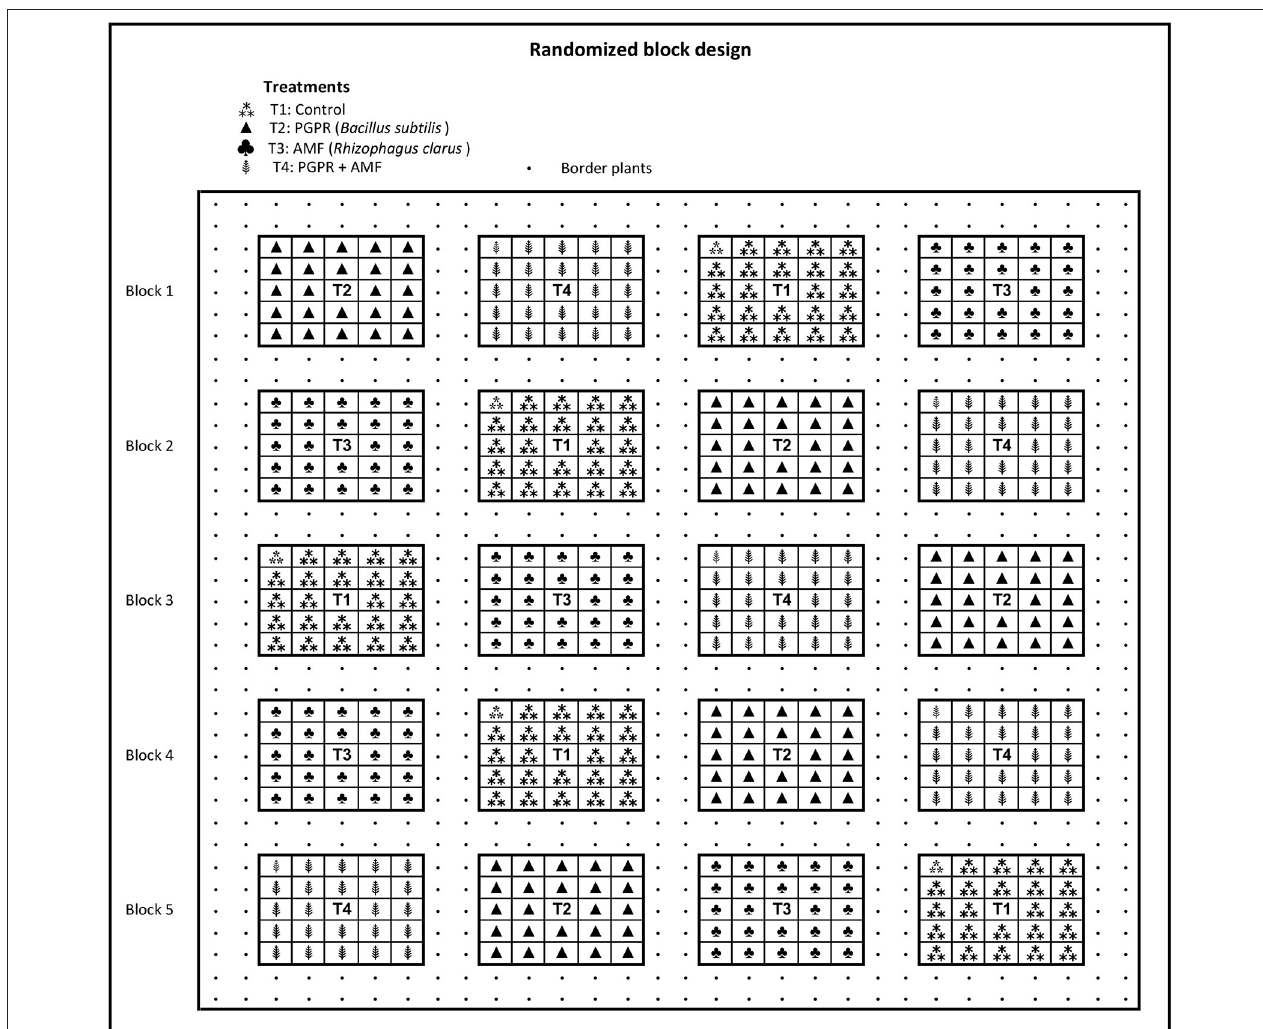
FIGURE 1 | Randomized block design of field experiments with Tectona grandis in states Mato Grosso and Pará, Brazil.